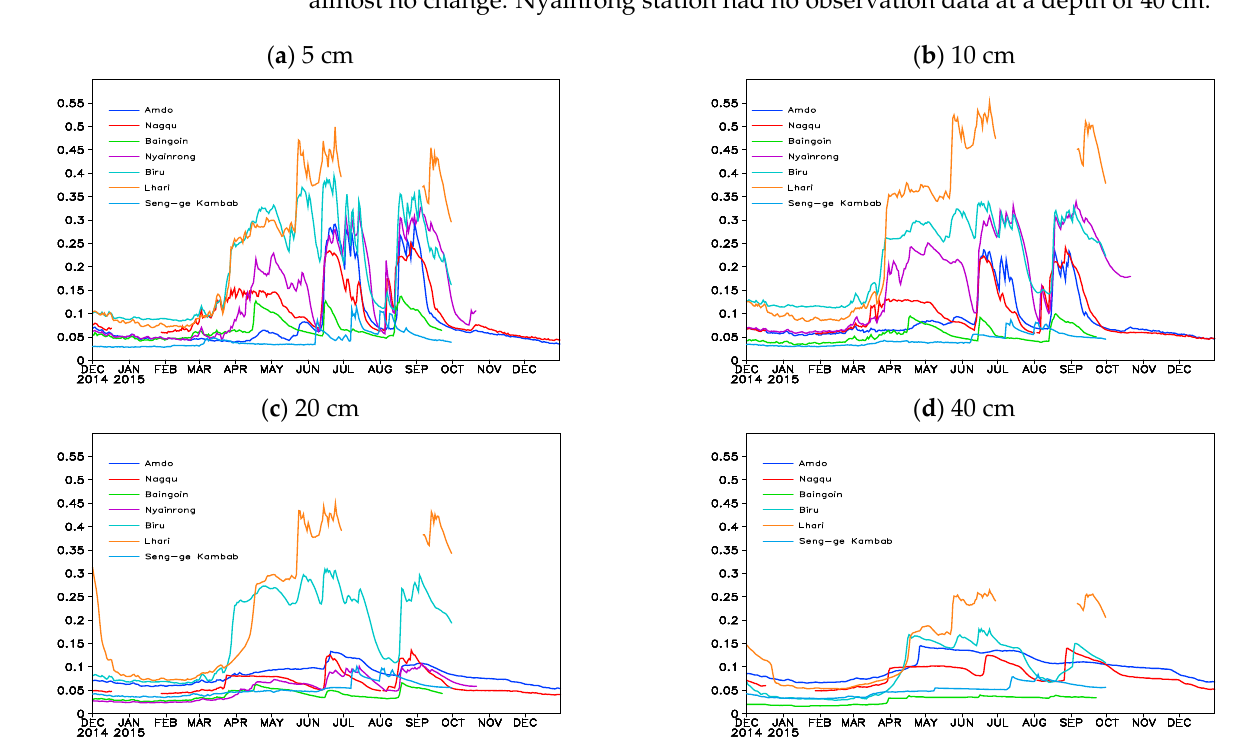
Figure 4. Time series of daily mean soil moisture at different depths for the seven observational sites (unit: cm 3 /cm 3 ).